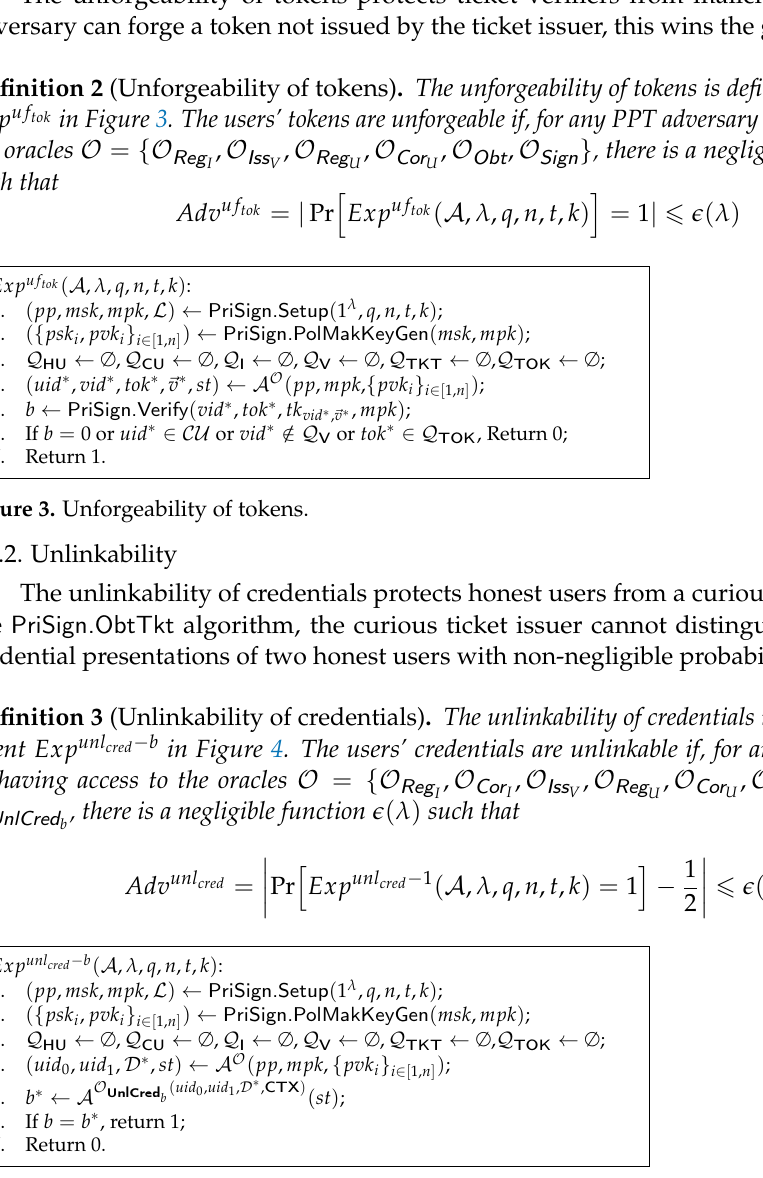
Figure 4. Unlinkability of